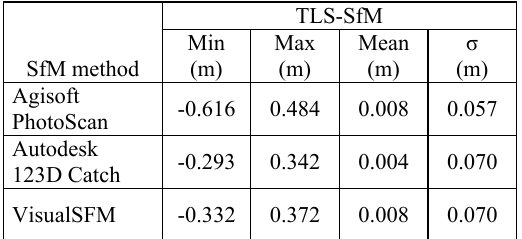
Table 2. Statistics of elevation differences between the different SfM DSMs and the TLS DSM.